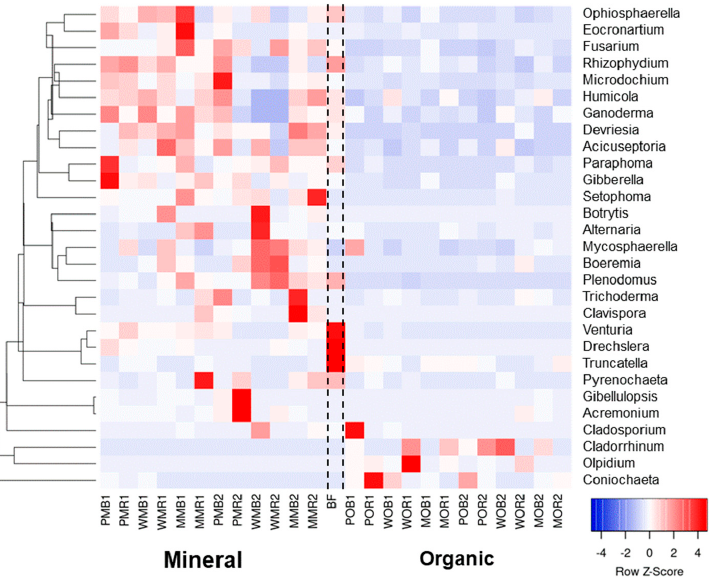
Figure 5. Relative abundances of major fungal plant pathogens plus biocontrol genera Cladorrhinum , Humicola , and Trichoderma in the total (DNA) fungal communities of the considered treatments at the genera level ( N = 3). The data are given as Z-scores. Abundances of fungal genera with positive z-scores are marked with red color, abundances with negative z-scores are marked with blue color. All soil samples are indexed according to the scheme: plant–fertilizer system–soil niche–sampling period. The following indices were used for (I) the crop species: P— potato, W—white mustard, M—maize; (II) fertilizer systems: M—mineral, O—organic; (III) soil niches: B— bulk soil, R—rhizo- sphere; (IV) periods of sampling: 1—June, 2—July. The bare fallow without fertilizers is marked as